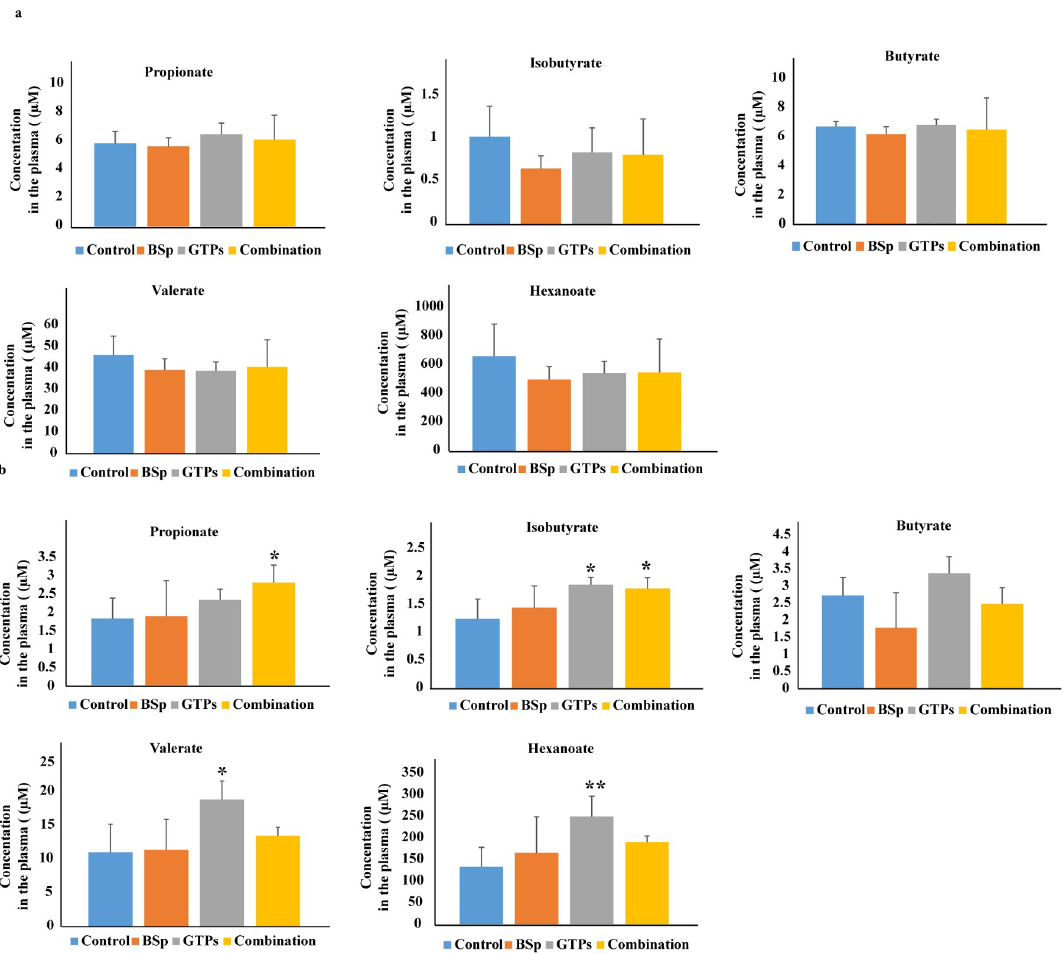
Fig 7. Analyses of plasma SCFAs levels in BSp-fed, GTPs-fed, combination-fed or control-fed mice. (a) Concentrations of SCFAs propionate, isobutyrate, butyrate, valerate and hexanoate in our dietary treatment mice versus control treatment mice in BE group (b) Concentrations of the SCFAs in BSp-fed, GTPs-fed or combination-fed mice when compared with control-fed mice in LC group. Data are presented as mean ± standard deviation (SD) (n = 6). Significance was determined by using one-way independent ANOVA, followed by Tukey’s post-hoc test. � p < 0.05, �� p < 0.01, ��� p < 0.001.